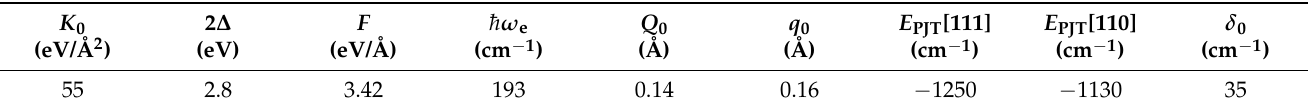
Table 1. Numerical values of the PJTE vibronic coupling and APES parameters of the Ti active centers in the BaTiO 3 crystal. E PJT [111] is the PJTE stabilization energy at the trigonal minima; E PJT [110] is the stabilization energy at the maximum of the barrier between two near-neighbor minima [9].